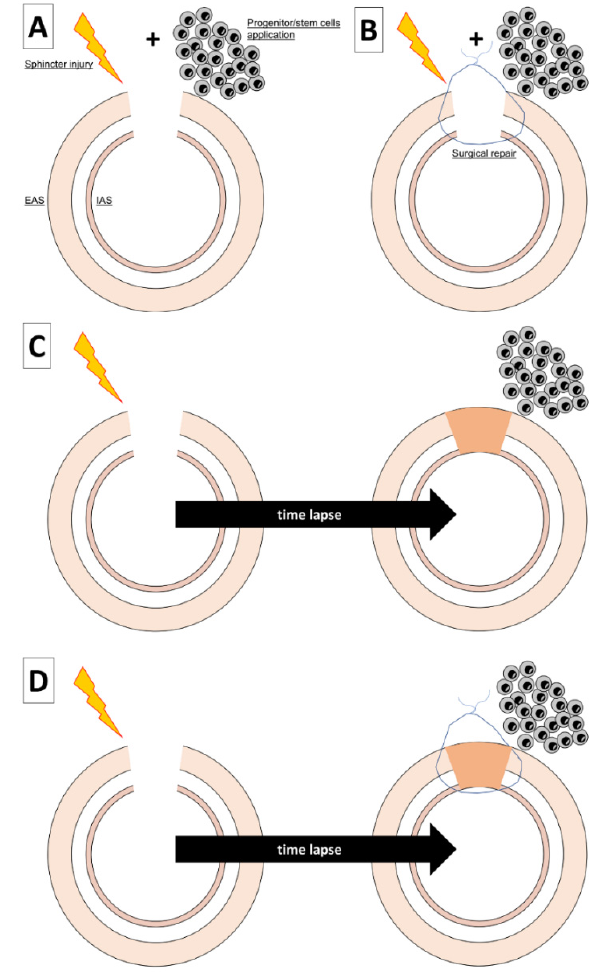
Figure 2. Cell therapy-based strategies for anal sphincter incontinence treatment. ( A , B ) Multipotent cells can be transplanted directly after injury with or without simultaneous reparation. ( C ) After injury, healing progresses but sometimes the muscle tissue is altered and responsible for ASI. Multipotent cells can be transplanted directly into the scar or in the neighborhood. ( D ) The best scenario could be to reinforce the surgical reparation of a sphincter defect with multipotent cells.